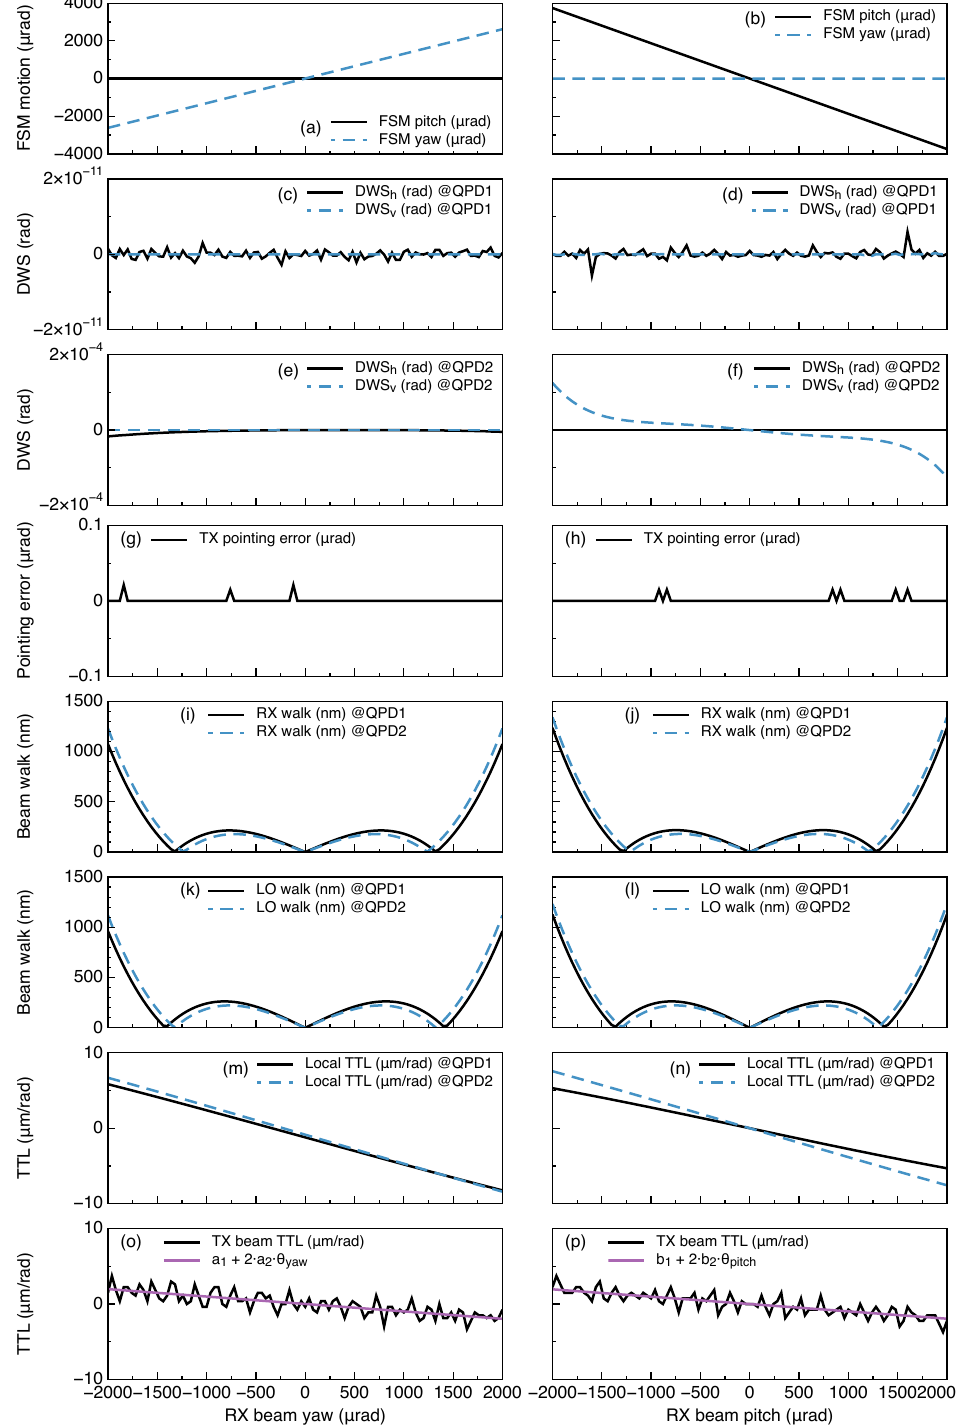
Figure 7. Angular motion of the local S/C causes the received beam’s incidence angle at the receive aperture to change (the abscissas). A steering mirror is actuated ( a , b ) via two independent DWS control loops that zero the DWS h and DWS v signals in QPD1 ( c , d ), keeping the RX and LO phase fronts nearly parallel at both detectors. QPD2 is out of loop and measures nearly zero DWS h and DWS v ( e , f ). The TX IS ensures that the TX beam is antiparallel to the RX beam in the inter-S/C path ( g , h ). The RX IS and LO IS ensure that the RX and LO beams experience minimal beam walk at the detectors ( i – l ). In the resulting configuration, TTL coupling is minimized, as measured both in the local S/C ( m , n ), and at the distant S/C ( o , p